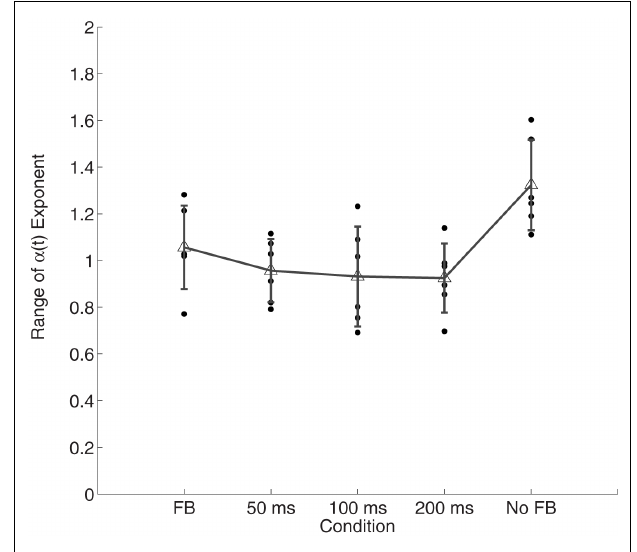
FIGURE 4 | Range of variability in α ( t ) as function of accuracy feedback. Individual points represent observations from individual participants. Error bars plot within-condition SD.